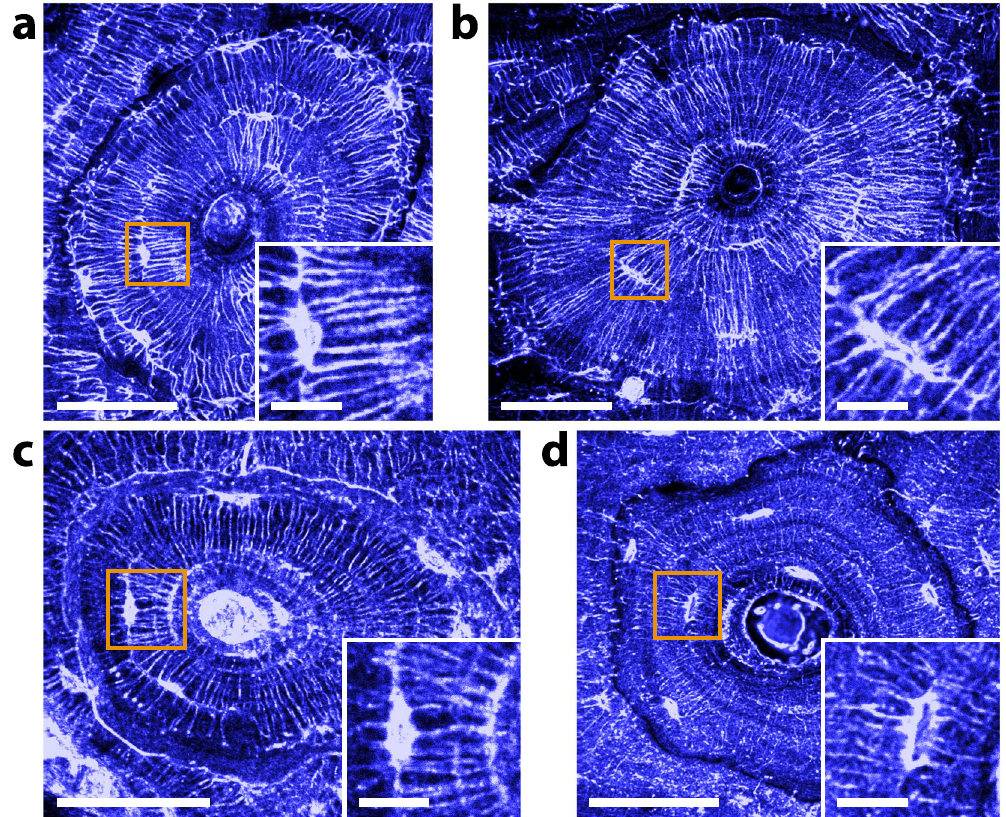
Figure 7. Effect of the sample preparation on THG imaging. THG images of ( a ), dehydrated; ( b ), fixed; ( c ), decalcified; and ( d ), resin-embedded transverse sections within the same bovine tarsis. Dehydrated and fixed samples yield similar THG images, while significant differences appear for decalcified and PMMA-embedded samples: in the former case, the modulation anticorrelated with the SHG signal is more pronounced and the cement line gives rise to a positive contrast. In the latter, the contrast of the canaliculi is reduced. Scale bars, 50 µ m. Insets, zooms into the orange squares. Scale bars, 10 µ